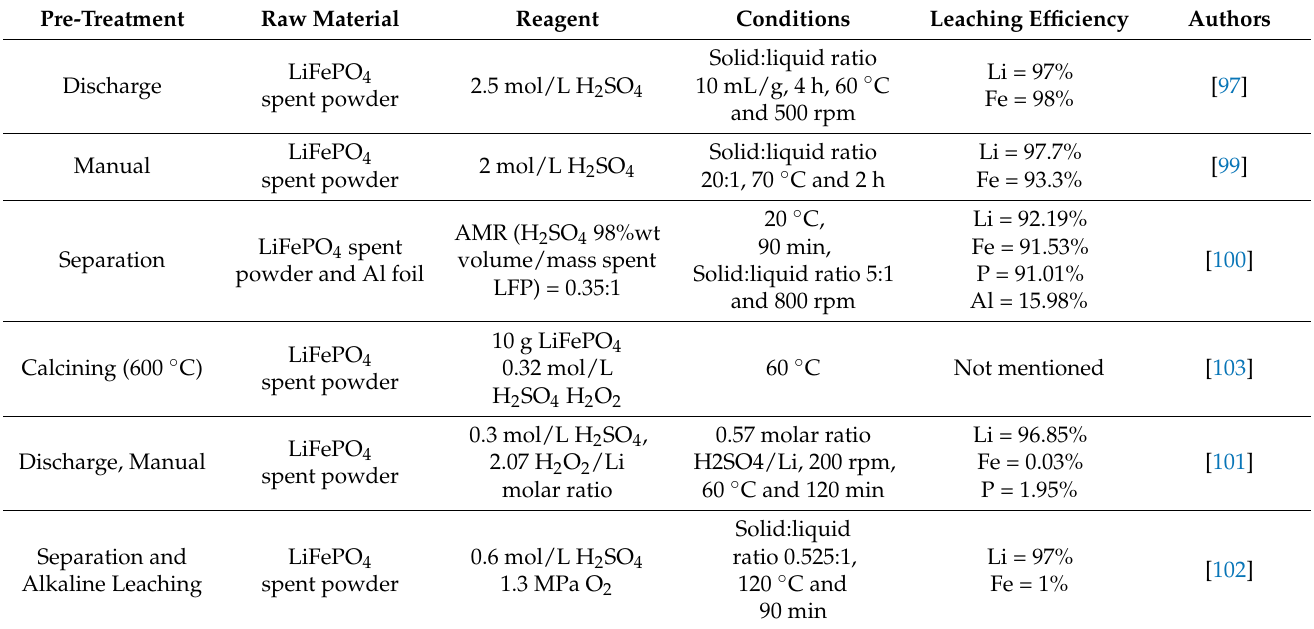
Table 3. Spent LFP cathode acid leaching treatment with the H 2 SO 4 leaching agent, comparing the leaching efficiency among